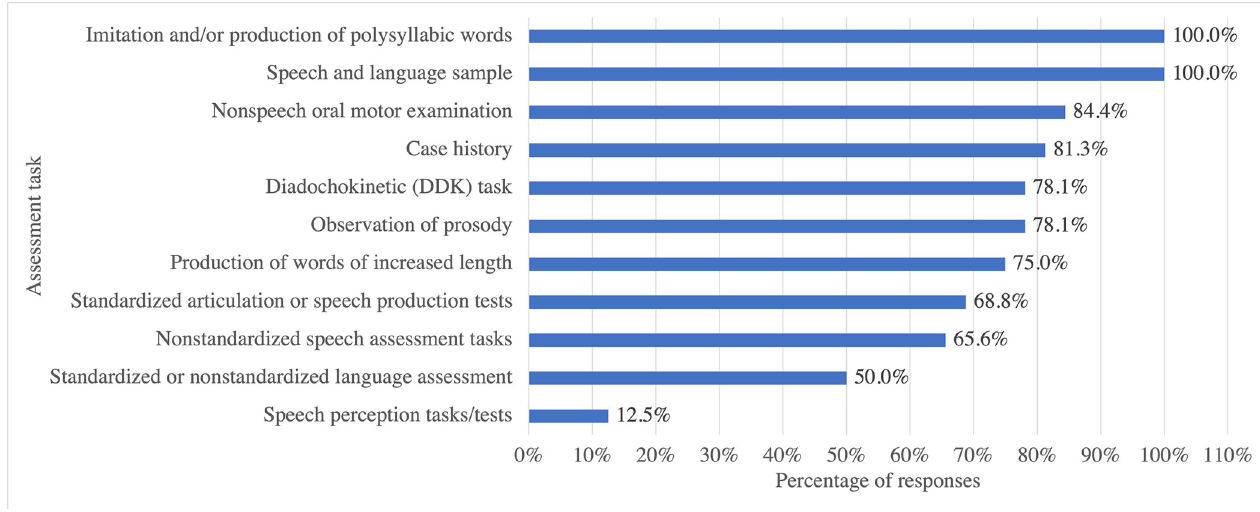
Fig 5. Percentage of respondents using specific assessment tasks for Cantonese speakers with or suspected with childhood apraxia of speech.